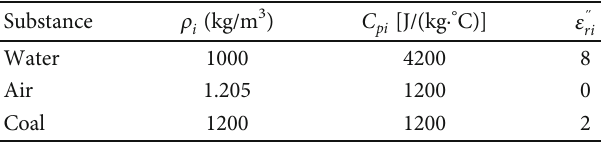
Table 3: Thermodynamic and electrical parameters of mixed substances [39 –